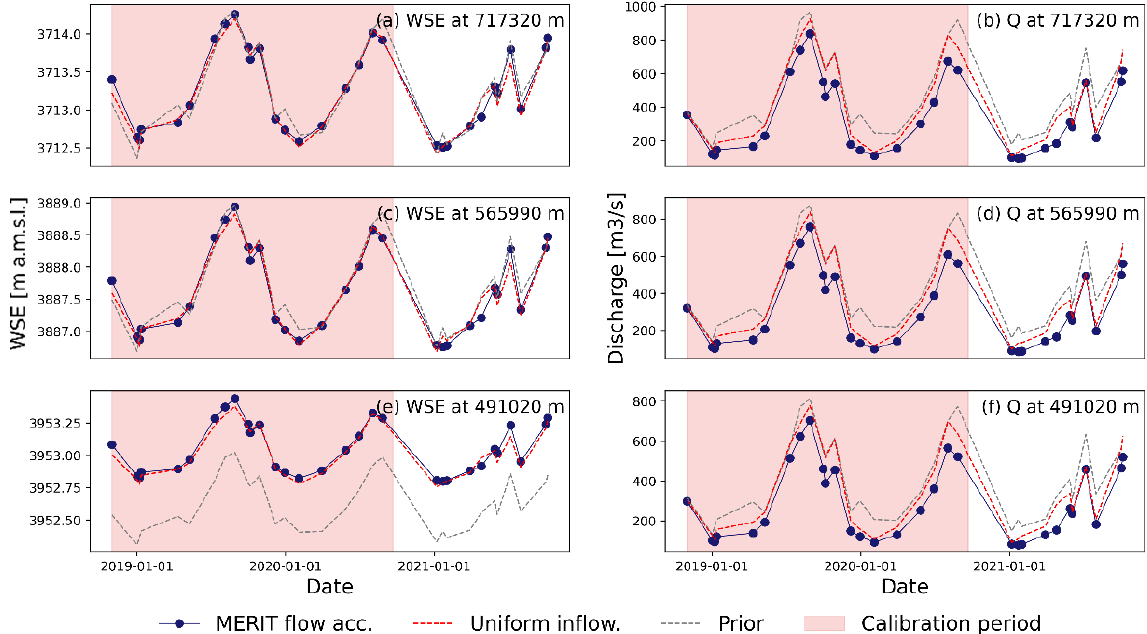
Figure 13. Simulated WSE (a, c, e) and simulated discharge (b, d, f) at selected chainage points. The simulated WSE and Q from the MERIT flow-accumulation-inferred parameters is compared with the results using uniform inflow and the prior guess.